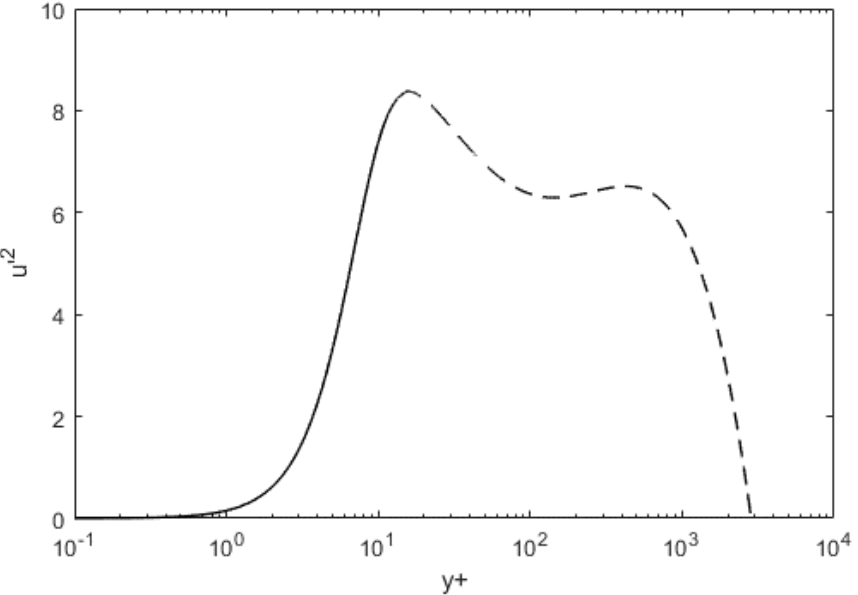
Figure A3. The primary peak near the wall is from the Weibull function, while the secondary structure is derived from numerical integration of the hypothetical sinusoid for du’ 2 /dy+ beyond y+ = 100.